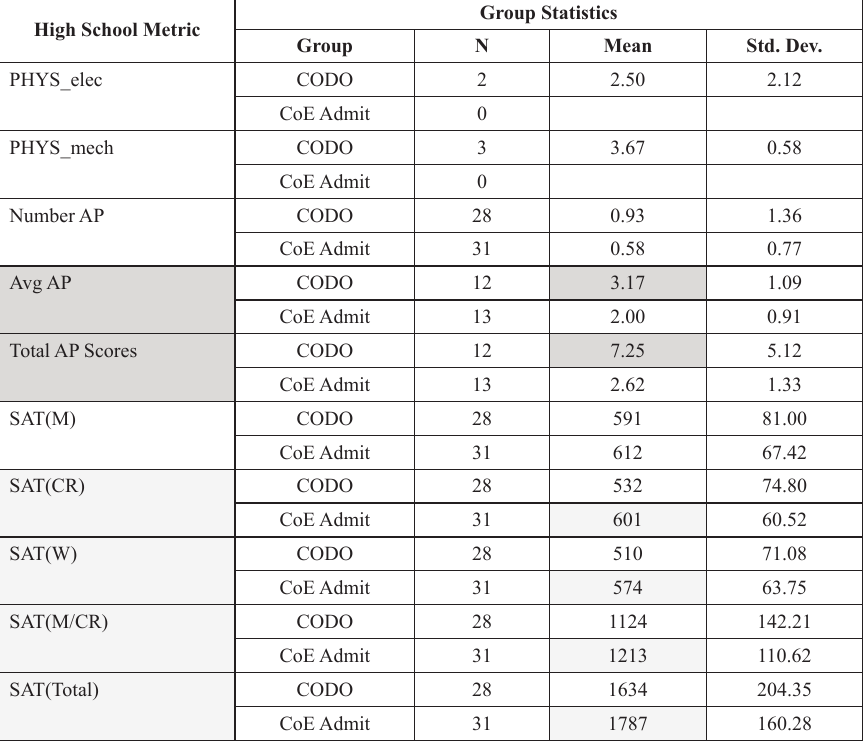
Table 5. Group statistics of High School Incoming Metrics compared between Change of Degree Objective (CODO) Graduates in the Purdue College of Engineering (CoE)